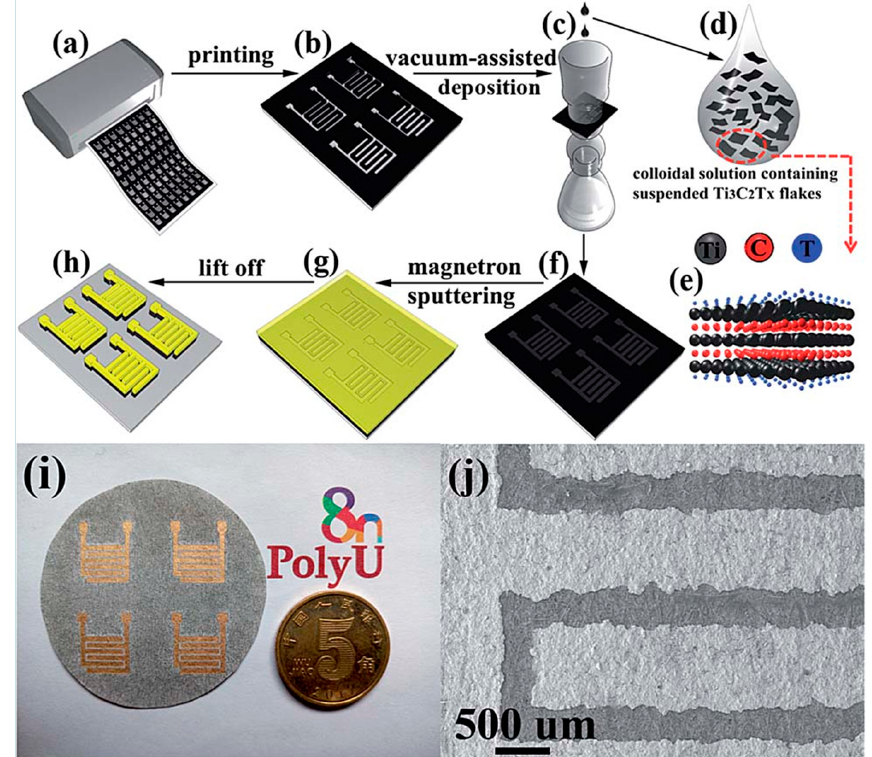
Figure 13. Flowchart of the easily manipulated protocol for patterning of fully delaminated few- layered MXene (Ti 3 C 2 T x ) flakes on paper for planar symmetric MSCs: ( a ) a common laser printer for printing an interdigital circuit template designed with drawing software; ( b ) paper substrate with the laser-printed template; ( c ) vacuum-assisted deposition of fully delaminated few-layered MXene flakes on the printed paper to fabricate the electroactive layer at the bottom; ( d ) schematic of colloidal solution containing fully delaminated suspended fewlayered MXene flakes; ( e ) schematic of the crystal structure of Ti 3 C 2 T x flakes (MXene); “T” symbolizes the surface atoms and atomic group, such as OH, F, and O; ( f ) the bottom binder/conductive-additive free electroactive layer based on few-layered Ti 3 C 2 T x flakes; ( g ) magnetron sputtering of a top Au film that served as a current collector on the electroactive layer at the bottom; ( h ) final lift-off to form the MXene-based planar MSCs; ( i ) a photo of the finished MXene-based planar MSCs; ( j ) the corresponding SEM photo of the fabricated interdigital electrodes of the devices, reprinted with permission from [137] .